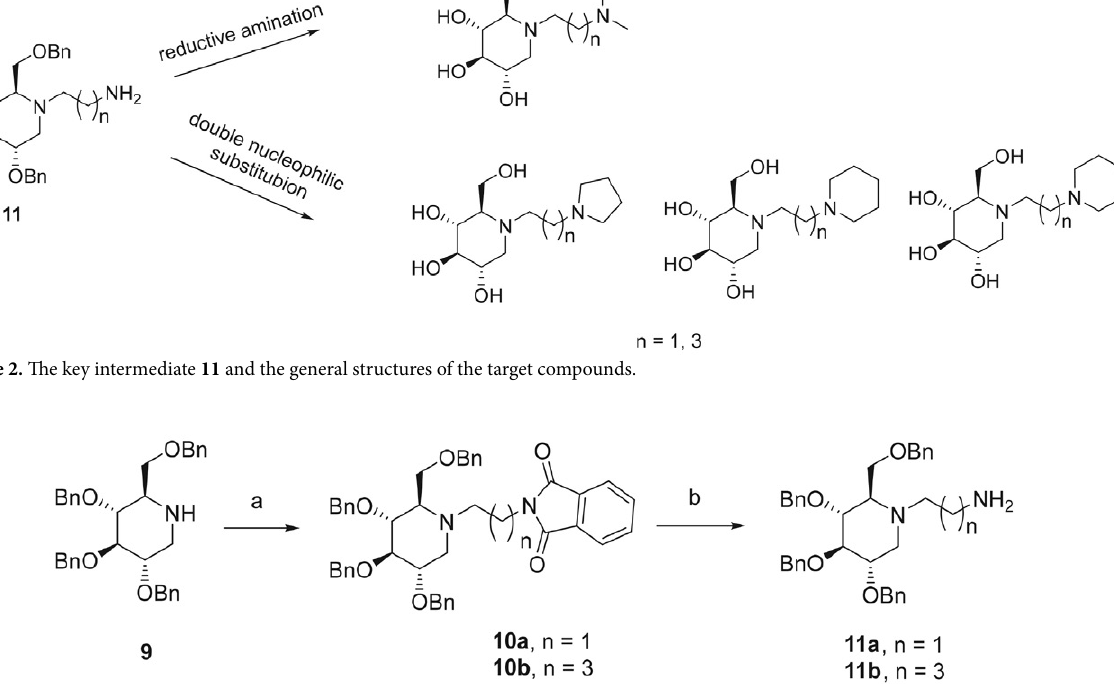
Scheme 1. Synthesis of the primary amide 11 . Reagents and conditions: (a) N -(4-bromobutyl) phthalimide or N -(4-bromoethyl) phthalimide, K 2 CO 3 , DMF, 100 °C, 24 h, 87% ( 10a ), 85% ( 10b ); (b) N 2 H 4 (80%), EtOH, reflux, 3 h, 82% ( 11a ), 85% ( 11b